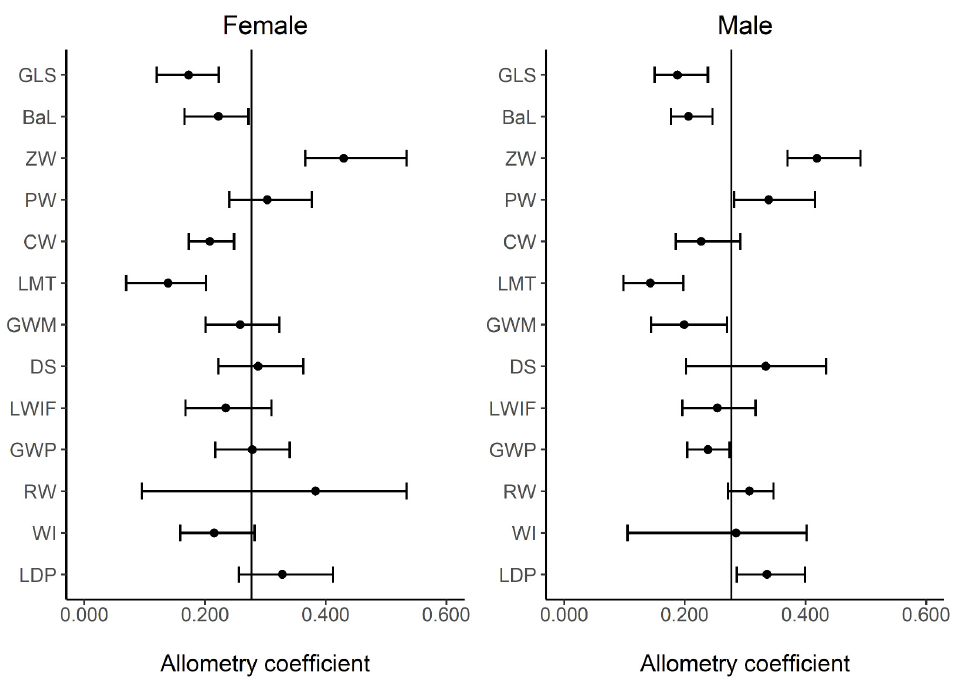
Figure 3. Multivariate allometry vector (the 1st eigenvector derived from the covariance matrix of ln-transformed variables) and 95% confidence interval using the bootstrap resampling procedure for skull morphometrics in each sex of introduced raccoons in Kamakura and Maizuru, Japan. The isometric value is 0.277 according to Jolicoeur [50]. Measurement letters corresponded to those of Figure 1. GLS, greatest length of the skull; BaL, basal length; ZW, zygomatic width; PW, paraoccipital width; CW, cranial width; LMT, length of maxillary tooth row; GWM, greatest width across first upper molars (M1s); DS, depth of skull; LWIF, least width between infraorbital foramen; GWP, greatest width across lower third premolars (P3s); RW, rostral width; WI, width of incisors; LDP, least distance between lower fourth premolars (P4s). Table 3. Multiple regression analysis for principal component (PC) scores regressed against region, age class, body length (BL), and body mass index (BMI) of female and male introduced raccoons in